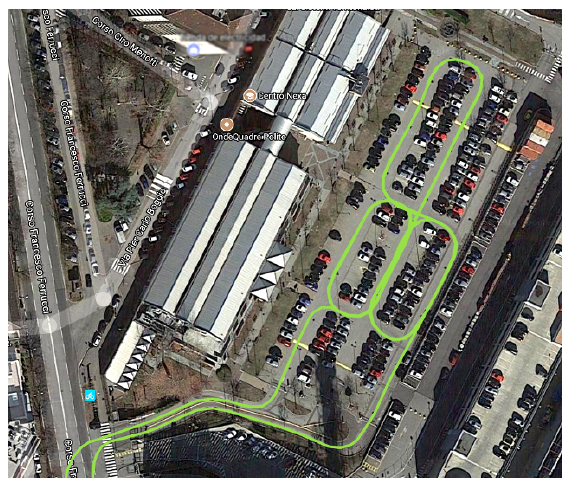
Figure 7. Trajectory during the calibration phase at a parking area at the Politecnico di Torino (image courtesy of Google Maps).